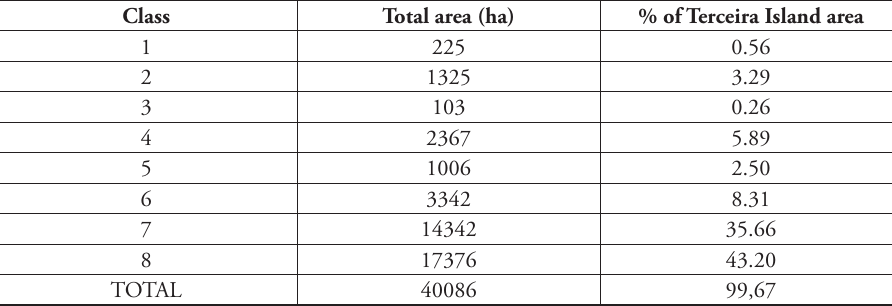
Table 2. Spatial assessment of bees’ abundance classes in Terceira Island.